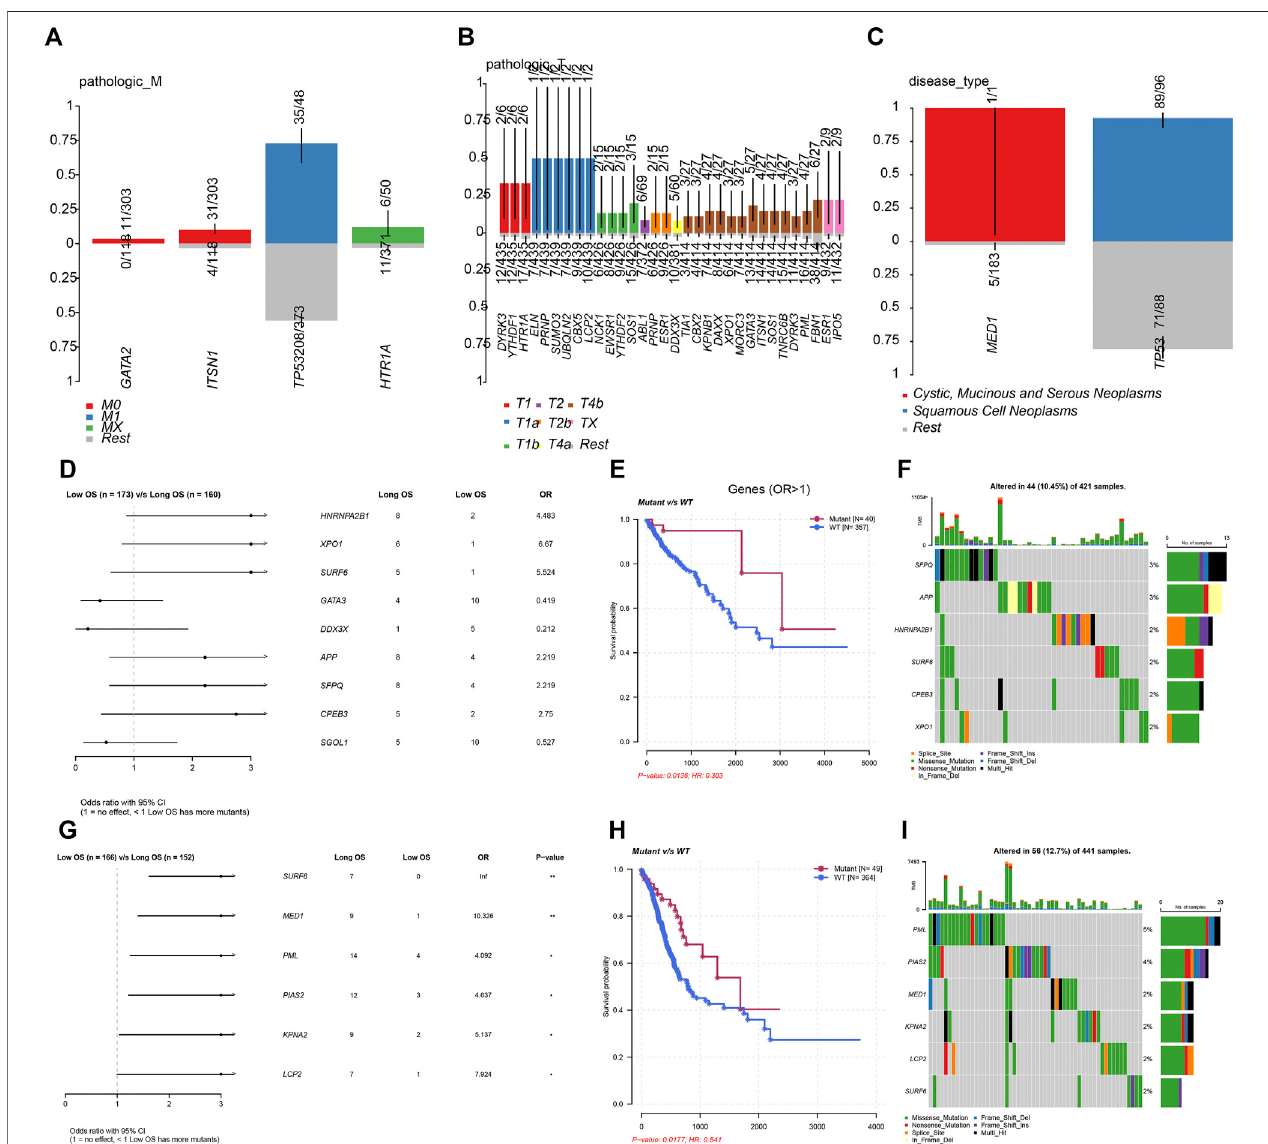
FIGURE 3 | Genetic alterations of LLPS regulators were related to the prognosis of digestive system neoplasms. (A – C) The enrichment of LLPS gene mutation in different type of pathologic M in COAD (A) , in different type of pathologic T in STAD (B) , and in different disease type of ESCA (C) . (D) The Cox regression of LLPS gene mutation corresponding to the OS in COAD. (E) The LLPS gene mutation signature indicated the good prognosis in COAD. (F) The landscape of LLPS gene mutation signature in COAD. (G) The Cox regression of LLPS gene mutation corresponding to the OS in COAD. (H) The LLPS gene mutation signature indicated the good prognosis in COAD. (I) The landscape of LLPS gene mutation signature in COAD.